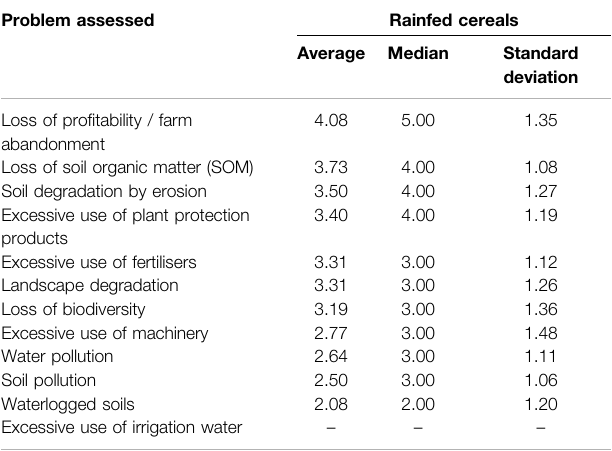
TABLE 1 | Stakeholders ’ qualitative subjective assessment and rating of the severity of agro-environmental problems in rainfed cereal-based cropping